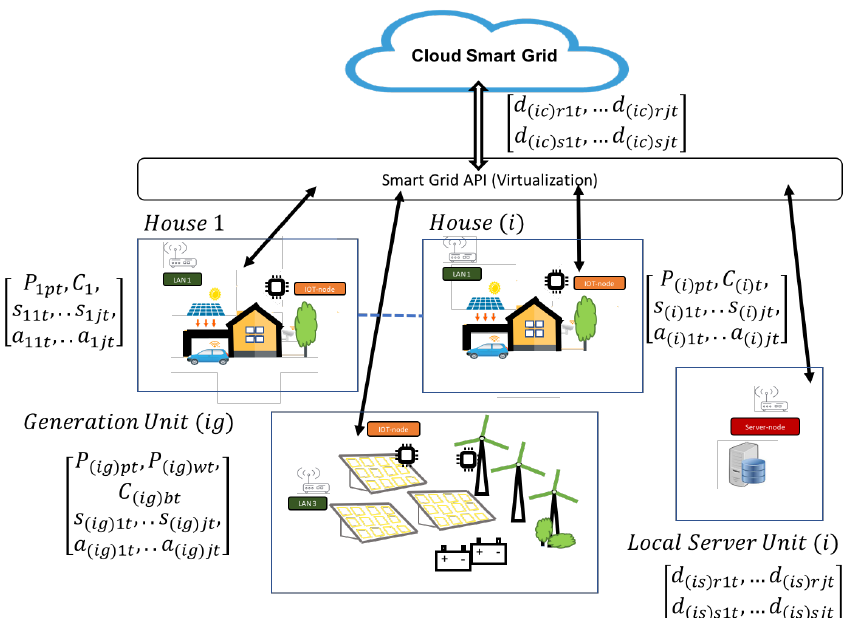
Figure 9. Model design: architecture diagram. Legend: P ( i ) pt −→ photovoltaic-generated power in house ( i ) in time t , ∀ i = 1,2, . . . n with n = house , C ( i ) t −→ power consumed in house ( i